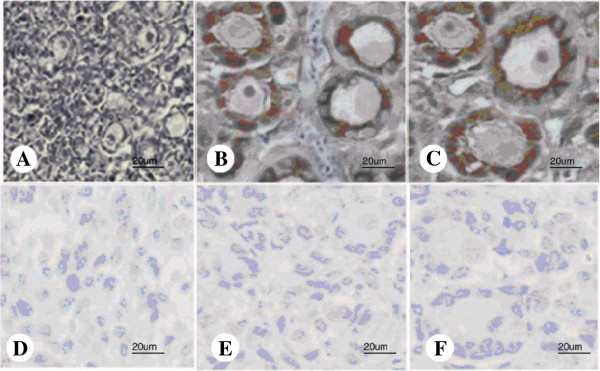
Expression of Src protein in rat ovaries during the activation and growth of primordial follicle were examined by immunohistochemistry analysis. Src protein expression in the oocyte and granulosa cell membrane of primordial and primary follicles (red arrows) is shown in A, B and C (which represent ovaries cultured in vitro for 0, 4 and 8 days, respectively). During the development of the follicles, the expression of Src protein increased corresponding. The negative controls are shown in D, E and F (which represent ovaries cultured in vitro for 0, 4 and 8 days, respectively).